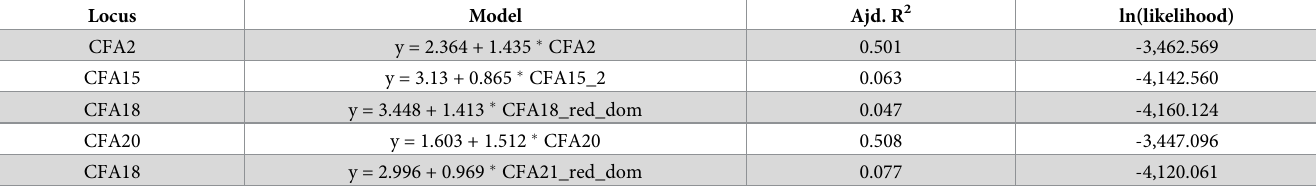
Table 4. Predictive power of individual loci.